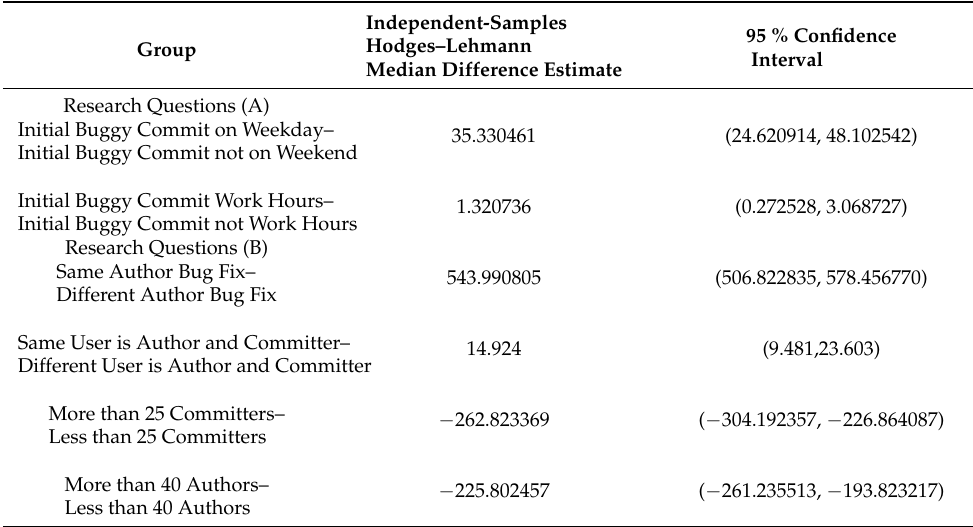
Table 3. Hodges–Lehmann Median difference results per research question.